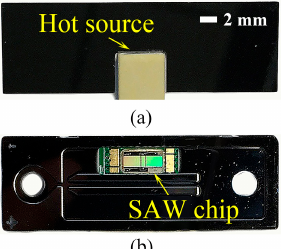
Figure 13. Photograph of a fabricated exploded sensor detecting probe: ( a ) the upper shell; ( b ) the lower shell .